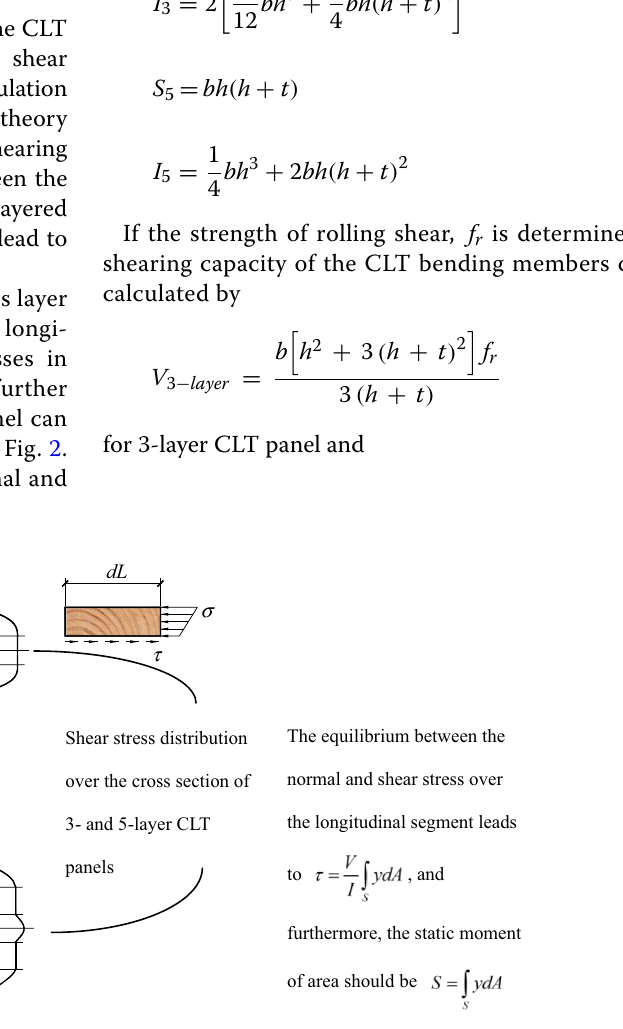
Fig. 2 Simplified beam model for the calculation of shearing